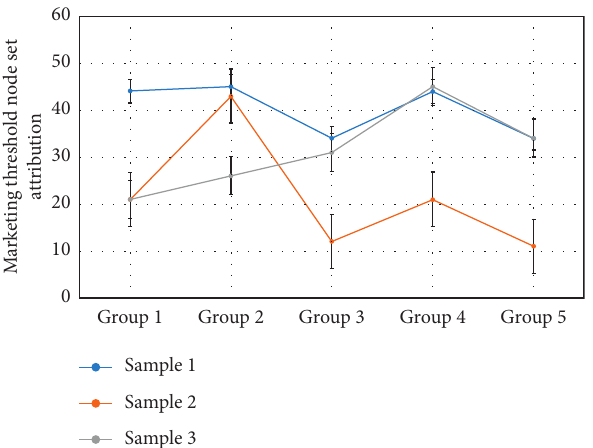
Figure 7: Normalized distribution of marketing threshold node set.